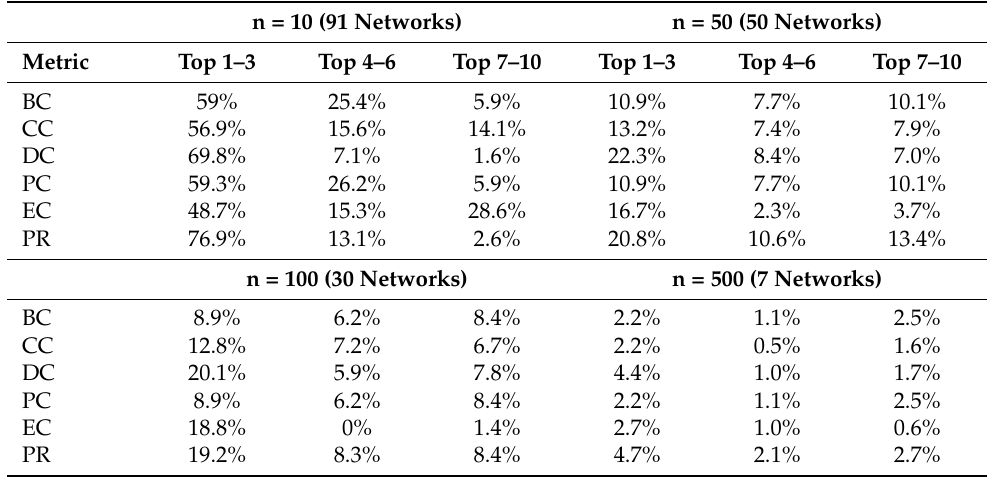
Table 9. Average percentage of HD nodes being top important nodes in different sized LFR networks. n = 10 (91 Networks) n = 50 (50